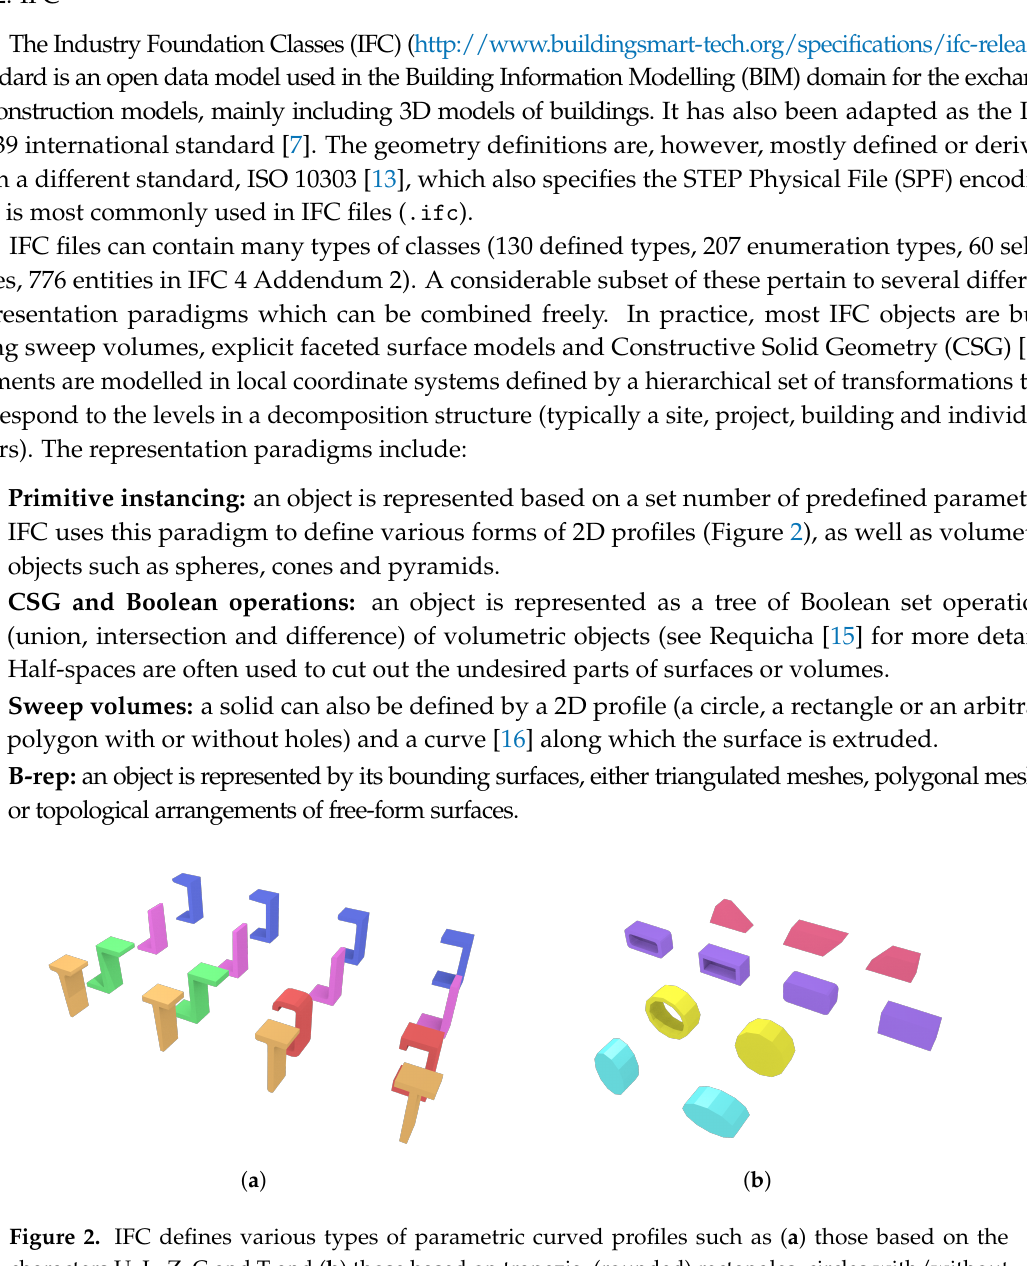
Figure 1. A building represented in LOD0 to LOD4 (image from Biljecki et al. [12]).